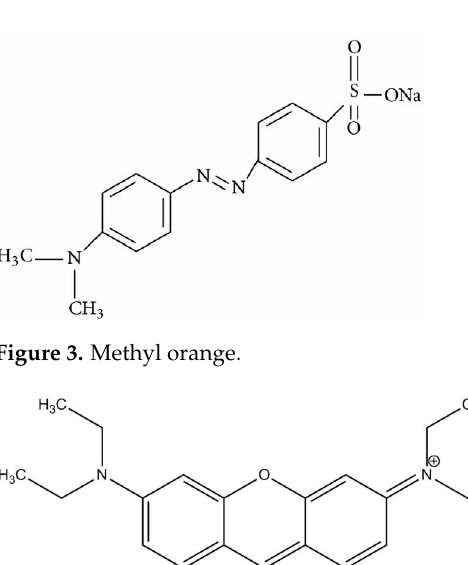
Figure 2. View of chemical polymerization of PANI and PPy on HEC.